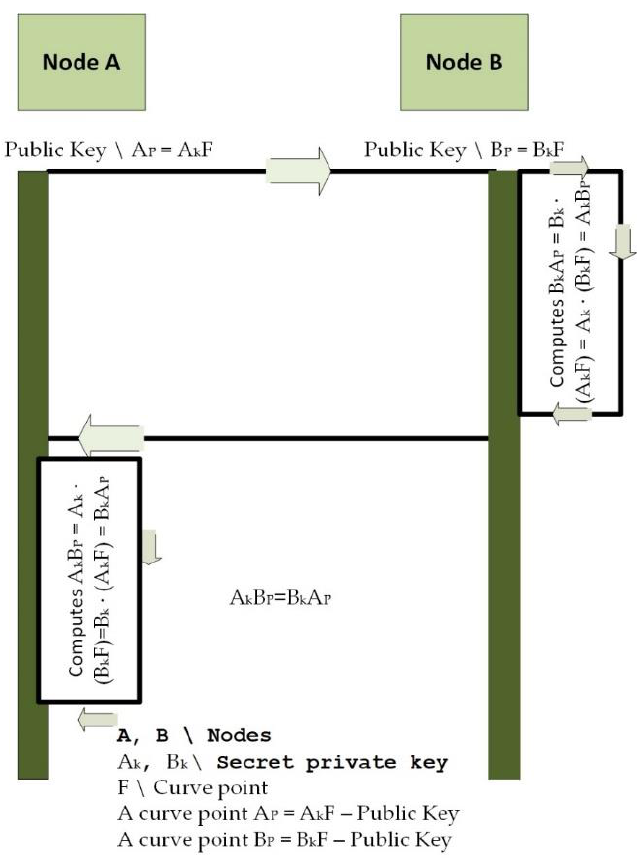
Figure 1. Elliptic-curve encryption.